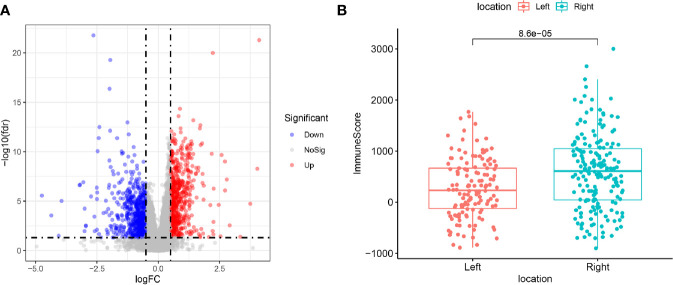

(A) Differentially expressed genes between left-sided colon cancers (LCCs) and right-sided colon cancers (RCCs). Red and blue circles indicate high and low genes expression, respectively. (B) Differences in immune score between LCCs and RCCs. LCCs and RCCs, left and right-sided colon adenocarcinoma.